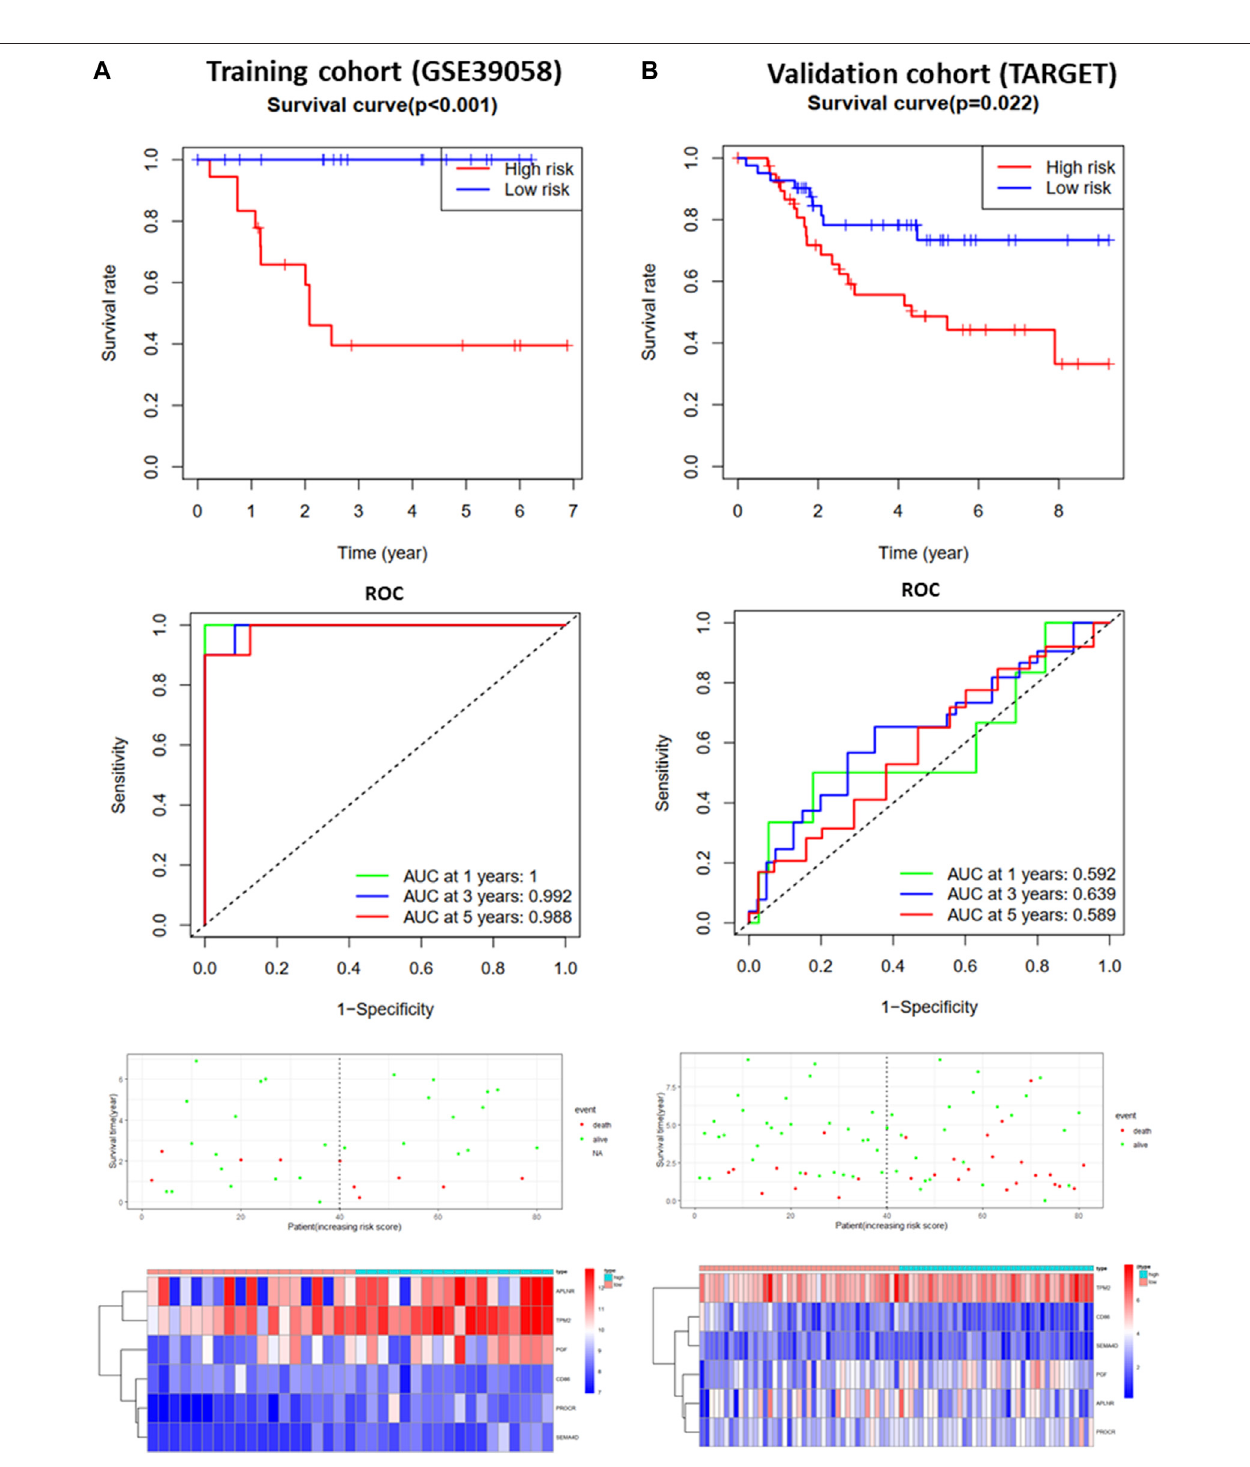
FIGURE 3 | Development and validation of the OS-prediction model for osteosarcoma. (A) Survival curve, ROC curve, survival status, and heat map for low- and high-risk subgroups in training cohort (GSE39058). (B) Survival curve, ROC curve, survival status, and heat map for low- and high-risk subgroups in validation cohort